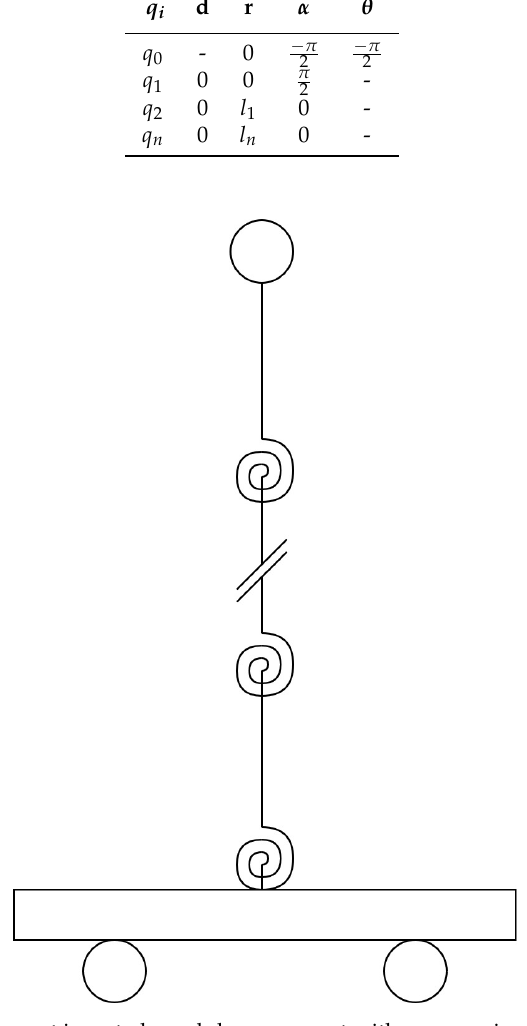
Table 3. Denavit-Hartenberg (DH) parameters.